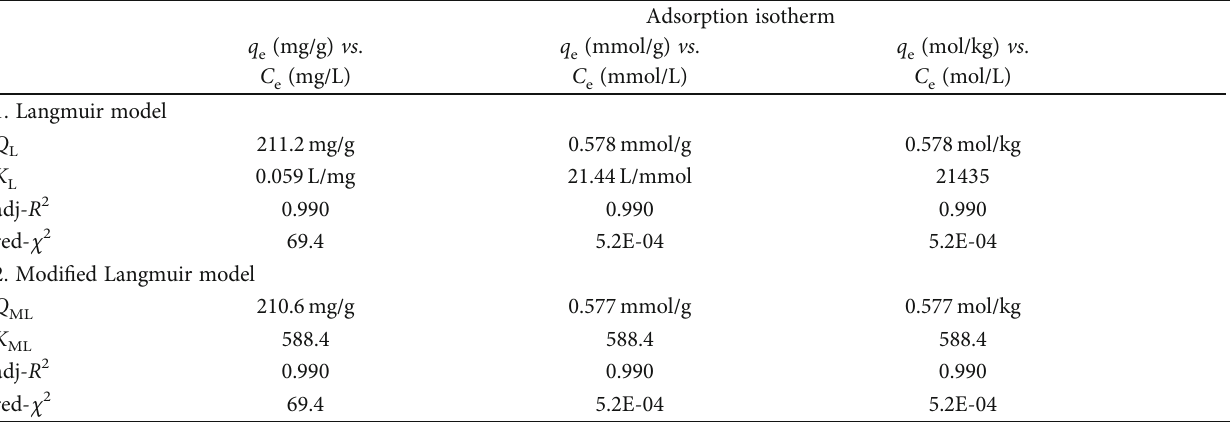
Table 12: Comparison of relevant parameters of the Langmuir and modi fi ed Langmuir models obtained from di ff erent units ( q the plots of MG adsorption isotherm by CAC